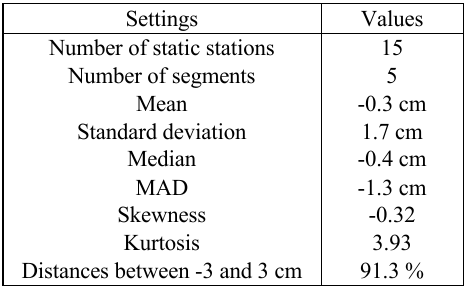
Table 4 . Statistical results for MMS cloud segmentation and reduction of the number of SLS